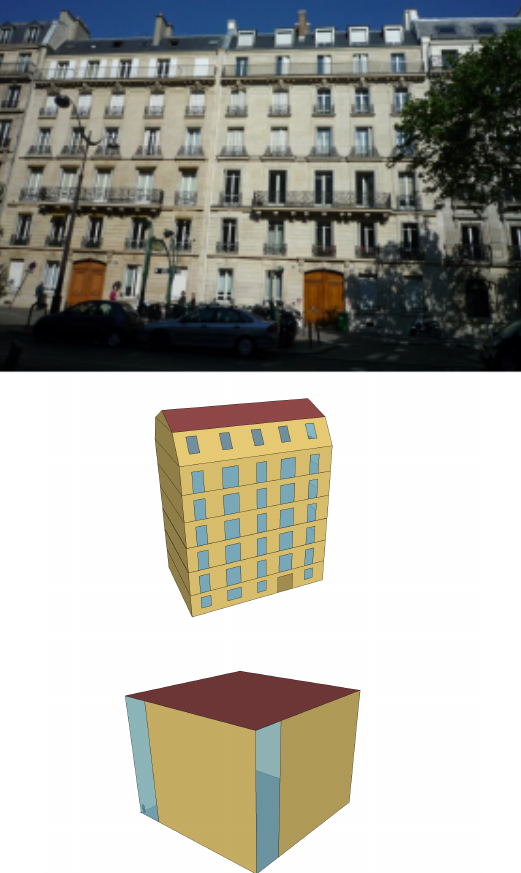
Fig. 3. Image of a Haussmannian building in Paris (top). Representation of the detailed model defined in EnergyPlus (middle). Representation of the simplified model defined in EnergyPlus (bottom).